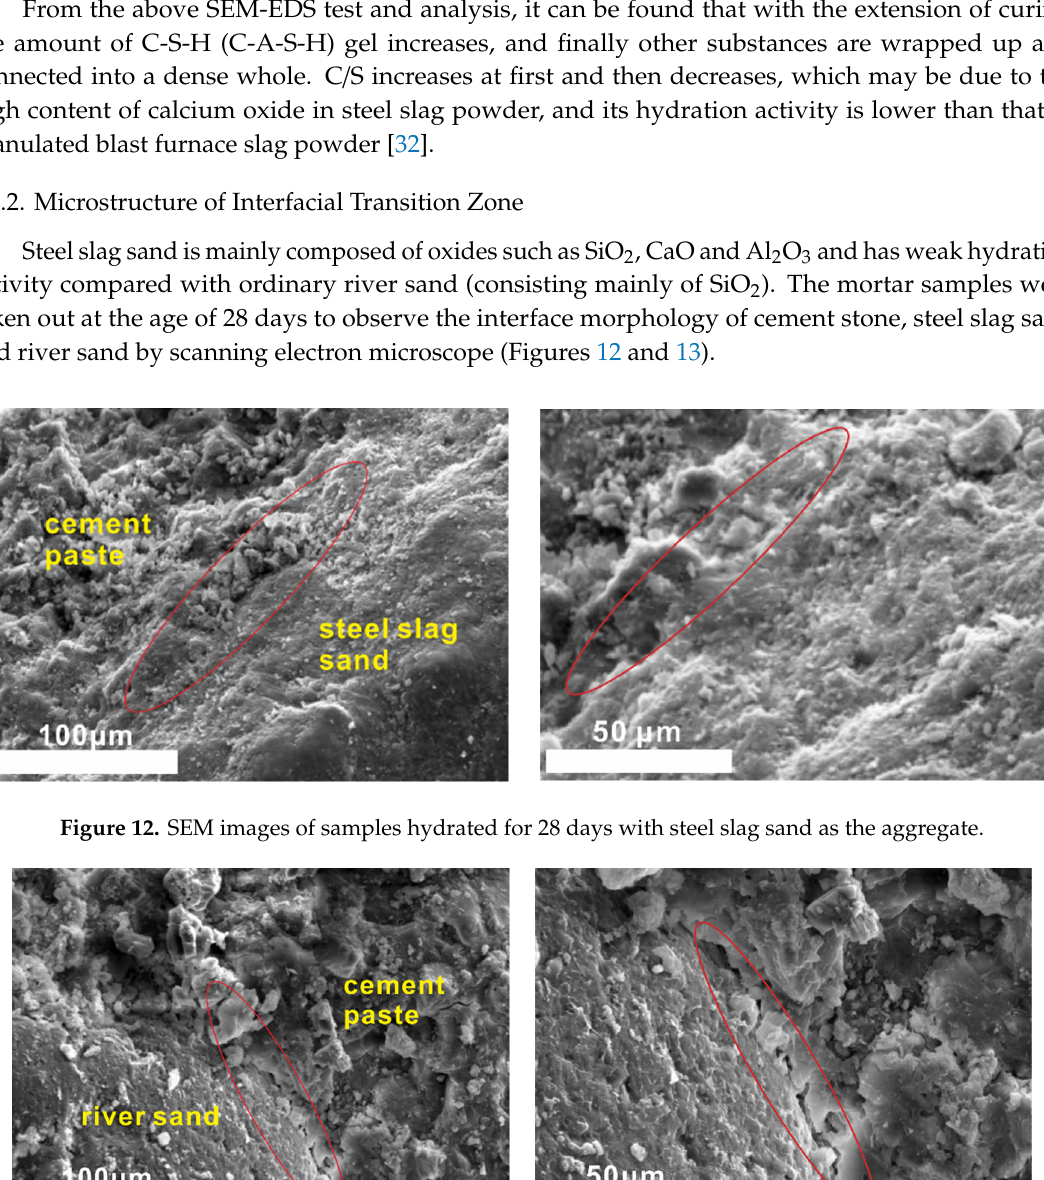
Figure 11. SEM-EDS of 28 days of curing samples. ( a ) SEM images of 28 days of curing samples. ( b ) EDS images of local region.